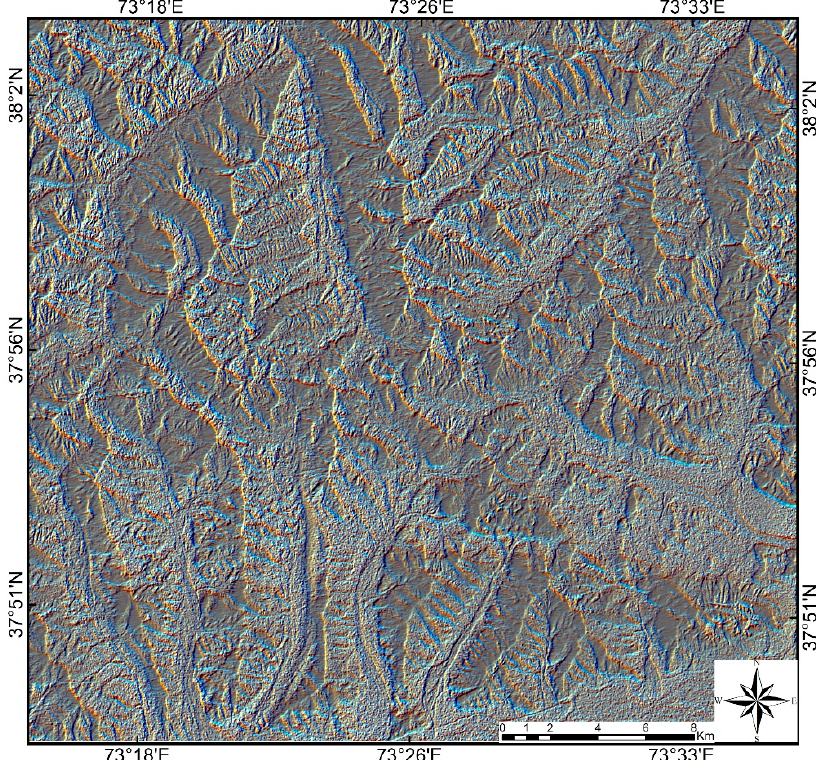
Figure 6. The colour composite image of the three optimal filtered directions in RGB (R (0), G (45), and B (90)) of S1A VH polarization used for manual lineament extraction.